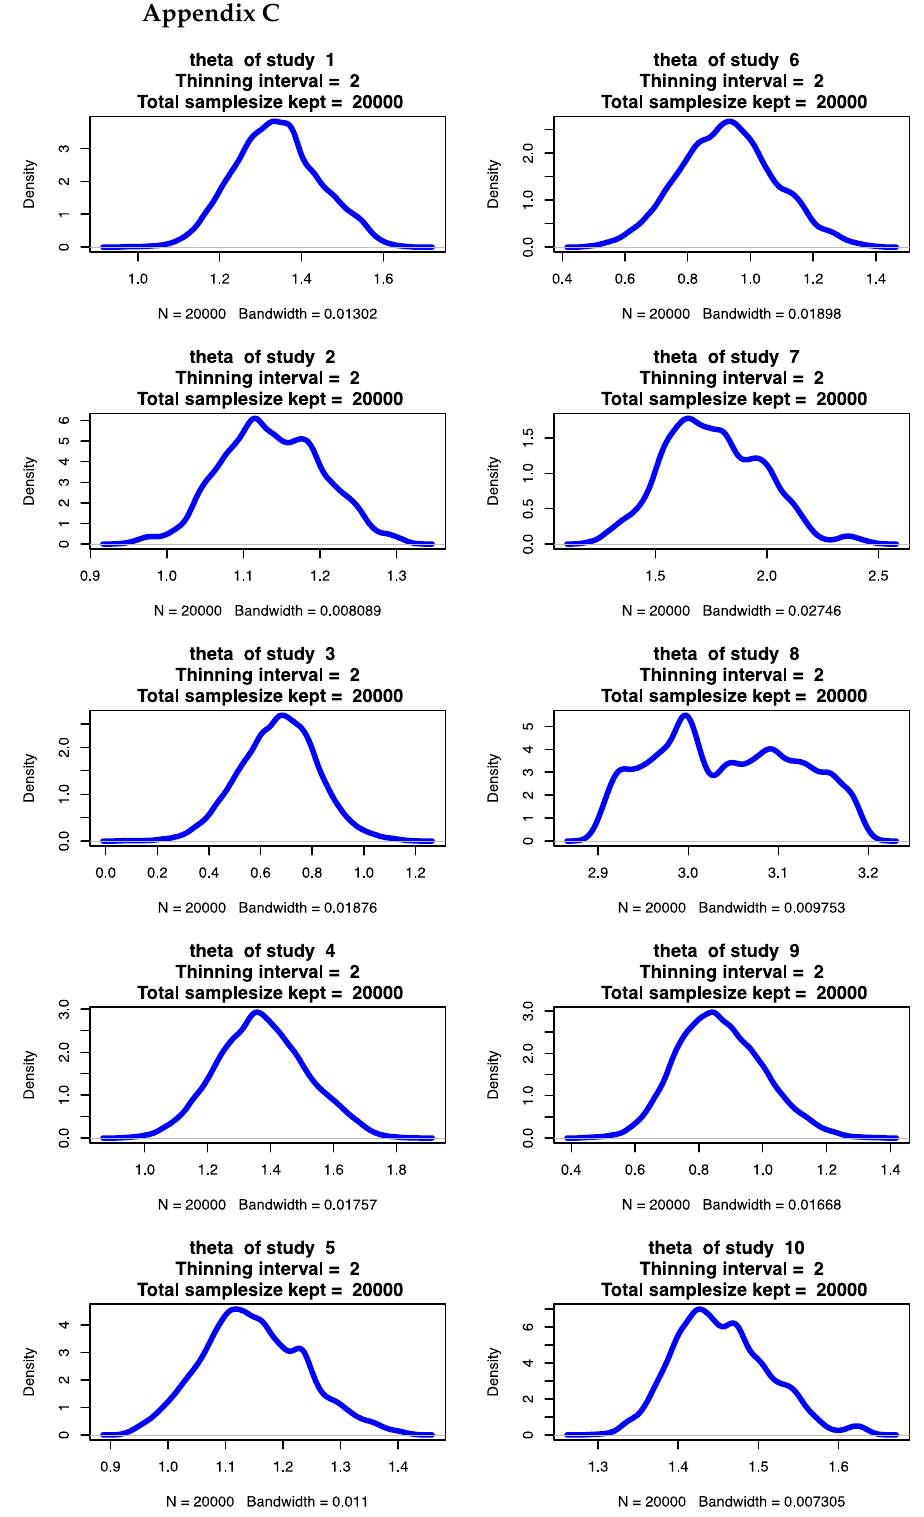
Figure A2. Posterior Distribution of the Parameters of the Hierarchical Summary Receiver Operating Characteristic Model.